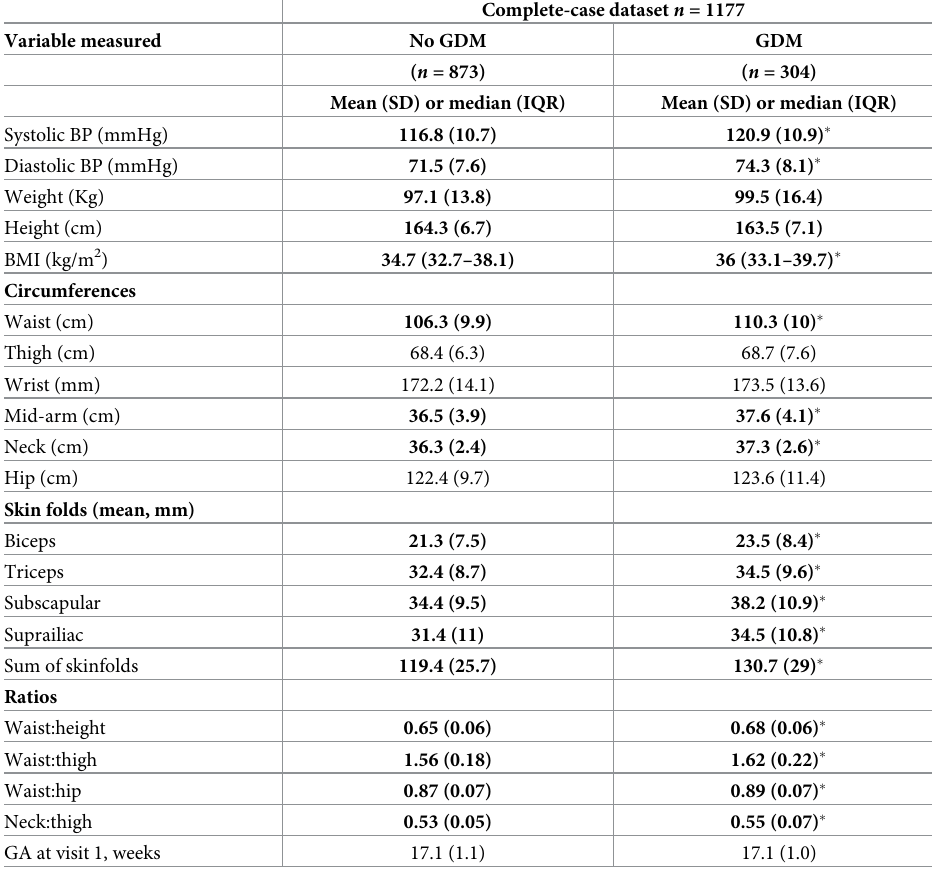
Table 2. Maternal clinical and anthropometric measures in early second trimester (mean 17 +0 weeks gestation) by GDM status (diagnosis at mean 27 +5 weeks’ gestation). Complete-case dataset n = 1177